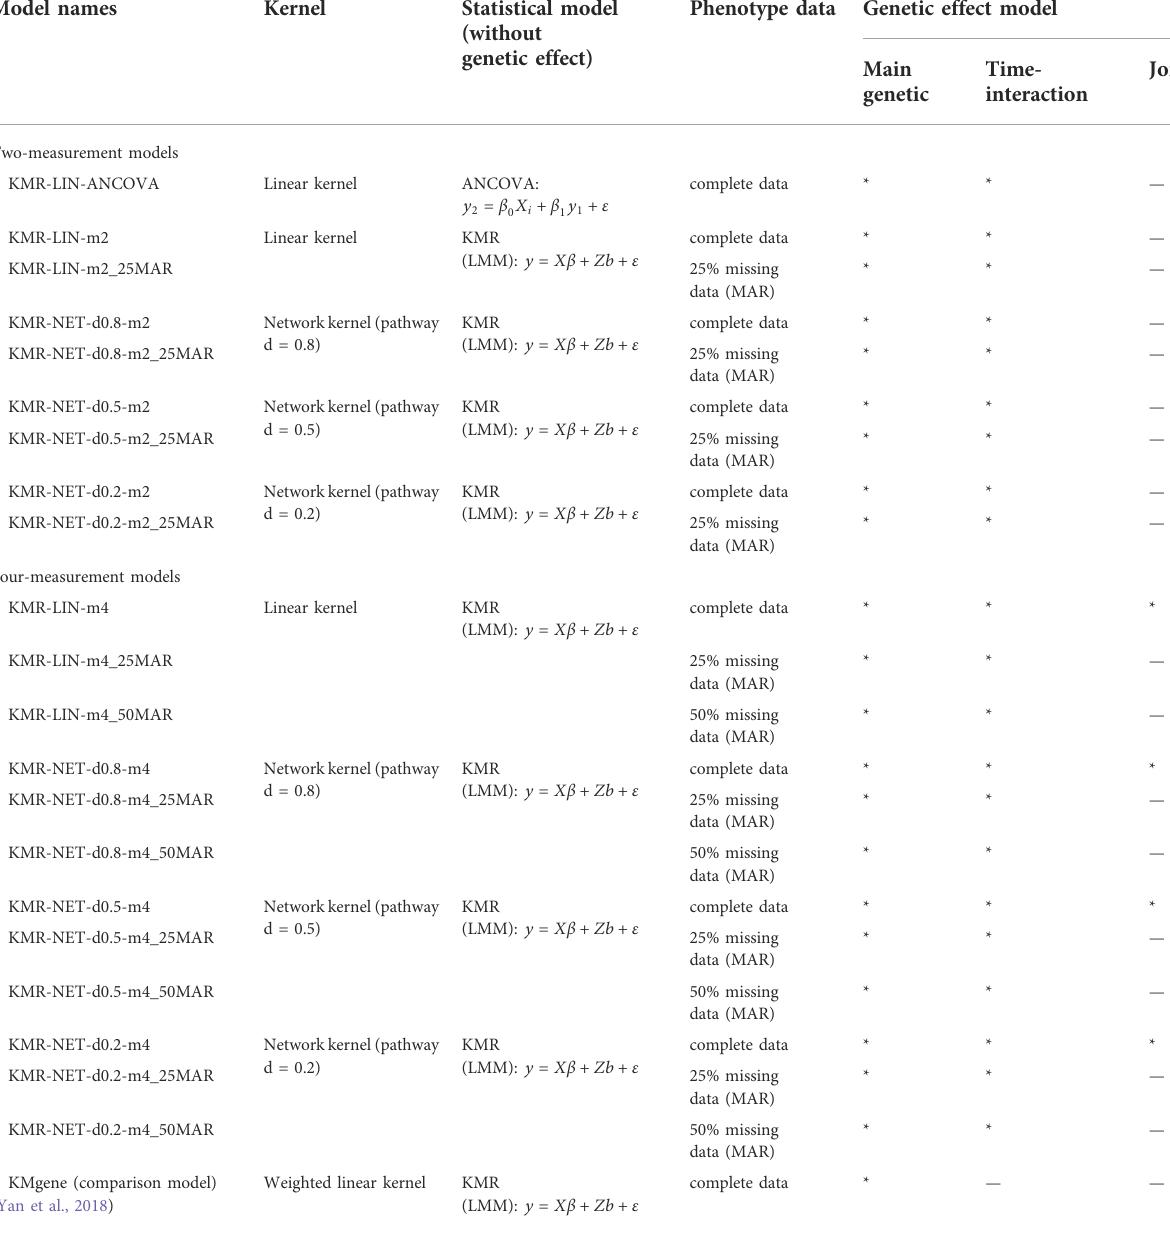
For each model, the kernel, the applied statistical models and the used phenotype data sets are displayed. For network kernel the pathway density (d) is given. The phenotype data can be complete or with 25/50% of values missing at random (MAR). The addressed genetic effects (main genetic, time-interaction and joint effect) are indicated with an asterisk “ * ” measurement points comparing two-measurement models with p -value < 5% threshold. In total, we compared the power for three four-measurement models. The type I error rates and respective different genetic effect models. We simulated two single-effect power of the linear kernel (LIN) and the network kernel (NET) models containing either a main genetic effect or a time- were compared. For the latter, we only used the unadjusted interaction effect. We also created a more complex model, the network kernel (NET), as all genes had the same size. For two joint model, which comprises a main genetic effect and a time- measurement points representing a pre/post-analysis, we applied interaction effect. The joint model was only studied in a limited the ANCOVA model (Table 1) to compare their performances number of scenarios, as portrayed in Table 1. For the single-effect with long-KMR. For the four-measurement models, we models, we had the same scenarios to evaluate the type I error compared the performance of long-KMR with the previously rates and the power. We assessed the in fl uence of the number of